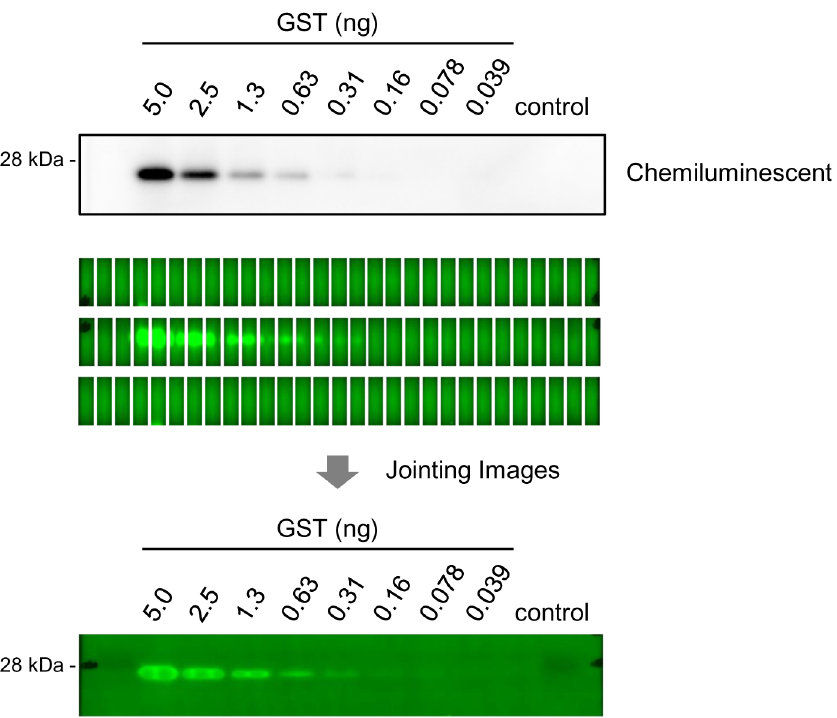
Fig 1. Joined image generated using fluorescence detection method. Dilution series of recombinant GST detected by our fluorescence method and by the chemiluminescence method. In our method, multiple images are captured using fluorescence microscopy, and joined to make a single image with a wide field and high resolution. The joined image has a broad area and high sensitivity comparable to that of the chemiluminescence method.